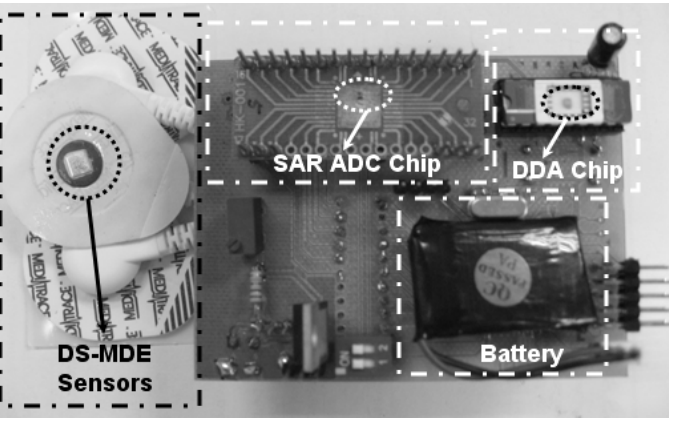
Figure 13. Picture of the proposed acquisition